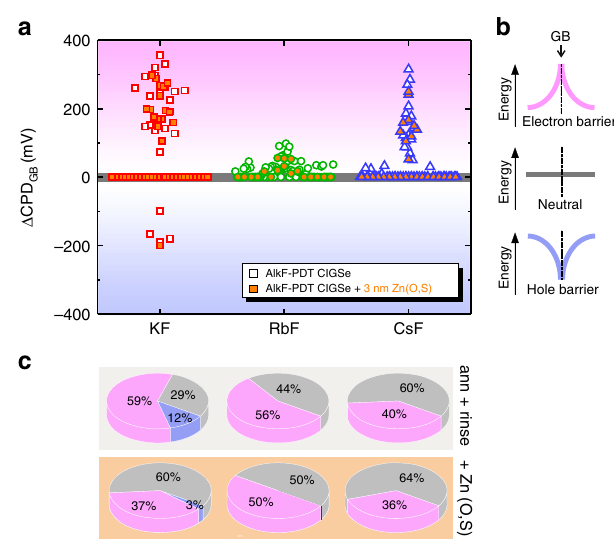
Fig. 3 Potential variations at grain boundaries. a Contact potential difference at GBs ( Δ CPD GB ) extracted from KPFM measurements in the dark on KF- (open red squares), RbF- (open green circles), and CsF-PDT CIGSe (open blue triangle). The orange- fi lled symbols correspond to identical samples with a Zn(O,S) buffer layer from an 8 min. CBD process. b Schematic potential pro fi les for the different types of GBs: negative Δ CPD Δ CPD GB or dip-like shape (blue), negligible GB or neutral (grey) and positive Δ CPD GB or spike-like shape (pink) and the corresponding models (hole or electron barrier). c Pie-charts indicating the proportion of the GB types found in CIGSe with different AlkF-PDT (top row) and on identical samples with Zn(O,S) layer (bottom